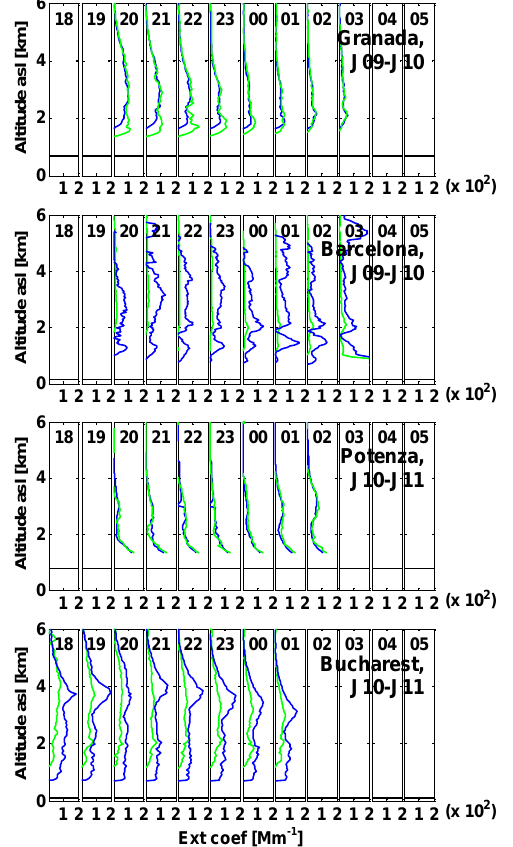
Figure 9. Time series of Raman-inverted extinction coefficient pro- files (SCC-2 product) at 355 (blue) and 532nm (green). The num- bers below the top axis indicate the time in UT. The horizontal black lines represent the station’s altitude